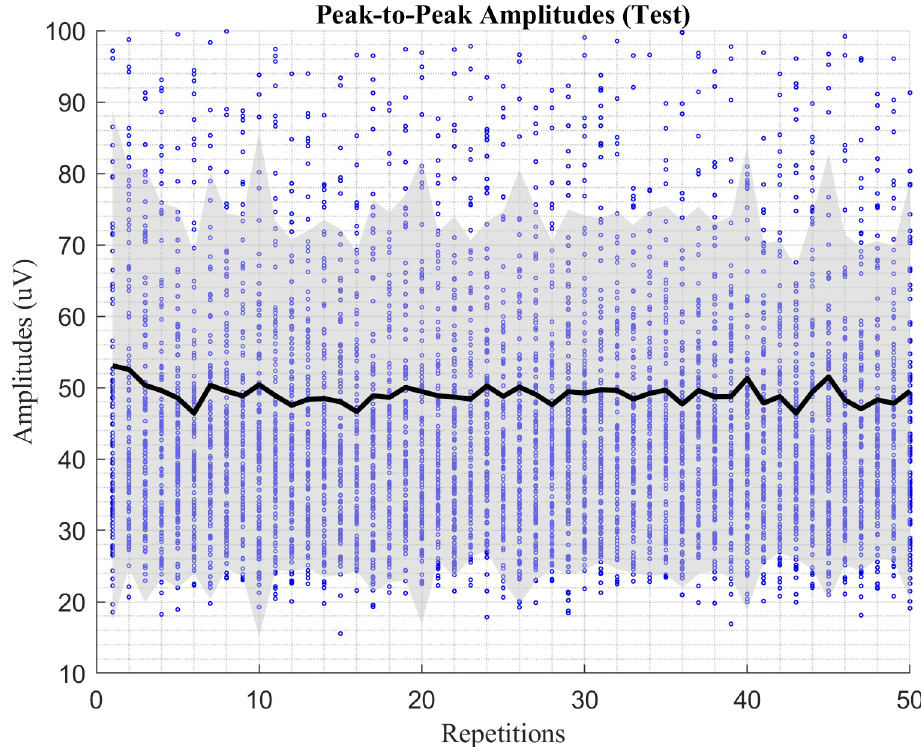
Fig 9. A scatter plot of the peak-to-peak amplitudes of all subjects over the stimulus repetitions in the ALR measurements (test session). The black solid lines indicate the mean of each repetition and the grey-filled area indicates the area under one standard